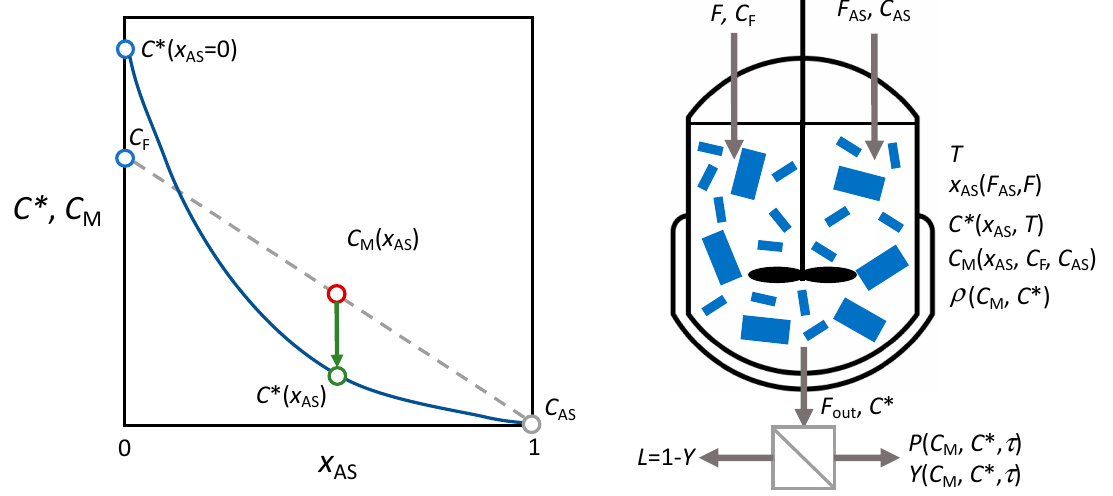
Figure 1. A schematic of the isothermal ternary phase diagram ( left ) for the development of a continuous antisolvent crystallization process ( right ). The feed solution with concentration C F and pure antisolvent are continuously fed into the crystallization vessel at temperature T and at specific feed rates for the solution F and antisolvent F AS with continuous product removal stream F out to provide a specific residence time τ and antisolvent fraction x AS . The overall concentration C M and the solubility C * determine the attainable suspension density r , the productivity P , the yield Y and the loss L .